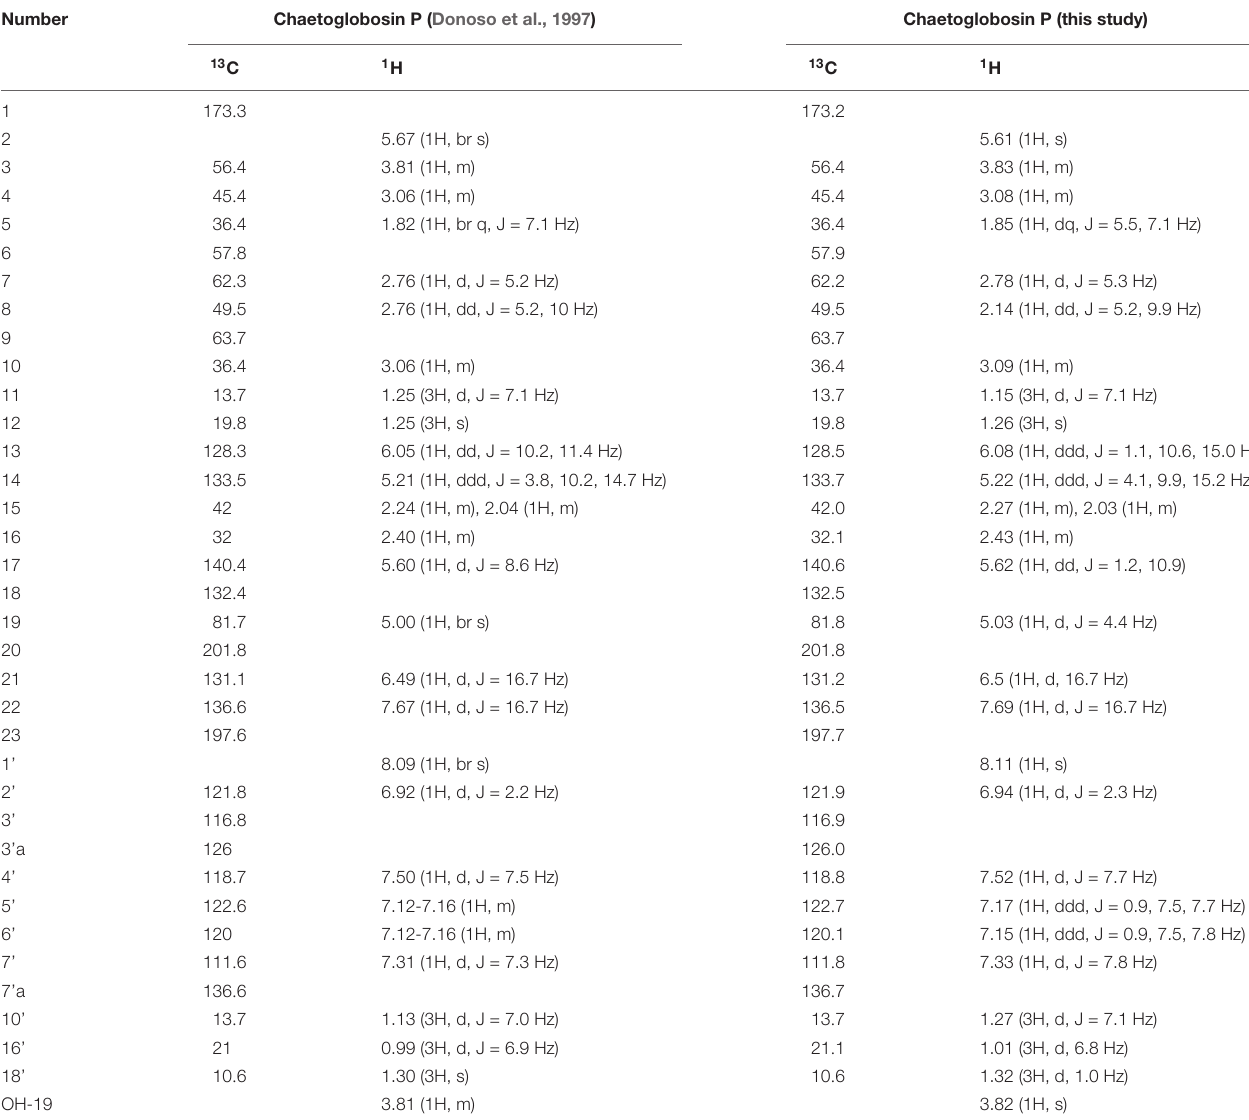
TABLE 1 | Comparison of 1H and 13C NMR chemical shifts of chaetoglobosin P purified in this study and the original data reported by Donoso et al. (1997). Number Chaetoglobosin P (Donoso et al., 1997) Chaetoglobosin P (this